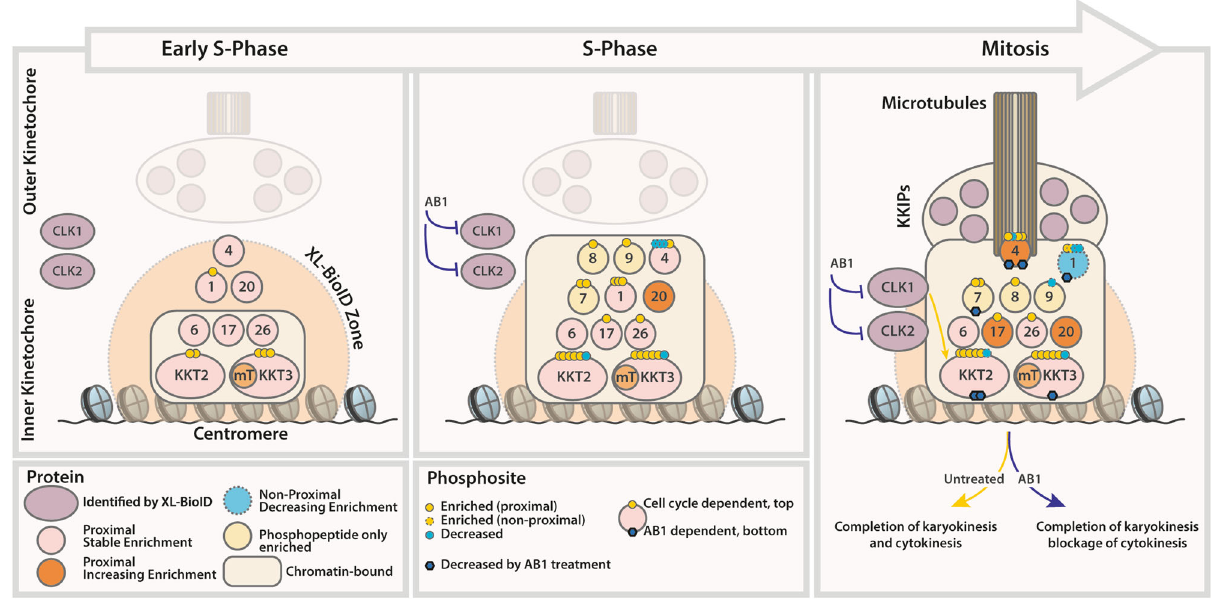
Fig. 8 Schematic representation of Leishmania kinetochore assembly and effect of CLK1/CKL2 inhibition by AB1, as inferred from XL-BioID proximity biotinylation data. MiniTurbo-tagged KKT3 (KKT3-mT, the bait) detects a core cohort of kinetochore subunits already present in the early S phase, which likely form part of the inner kinetochore bound to centromeric chromatin. Of these subunits, only KKT1 and KKT2 have detectable phosphorylation. Progression to S phase sees a large increase in phosphorylated kinetochore subunits and increasing enrichment of KKT4 and KKT20, but no detectable impact of CLK1/CLK2 inhibition by AB1. In mitosis, the kinetochore is fully formed and attached to microtubules of the mitotic spindle, possibly via KKT4, which has reached peak enrichment. At this stage, the consequences of inhibiting CLK1/CLK2 activity are detected as a reduction in phosphorylation of kinetochore subunits KKT1, KKT2, KKT3 and KKT4. Reduced phosphorylation of KKT7 is also observed, but we cannot exclude the possibility that this is due to reduced recruitment to the kinetochore. AB1-treated Leishmania can continue to complete nuclear division (karyokinesis) but are then arrested at cell division